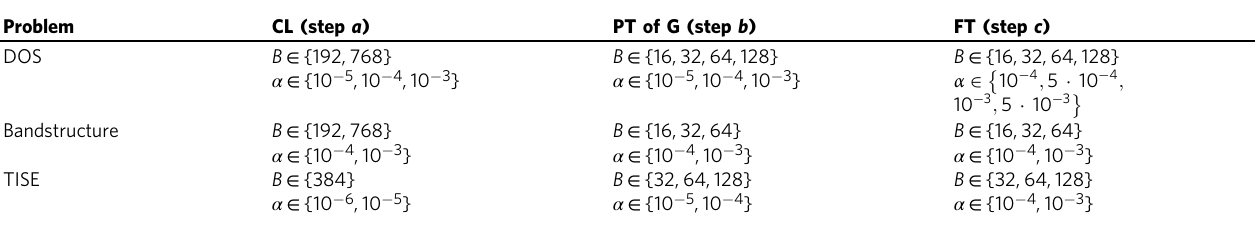
Table 4 Set of hyperparameters tuned over in the contrastive learning (CL), pre-training (PT) of G, and fi ne-tuning (FT) steps of